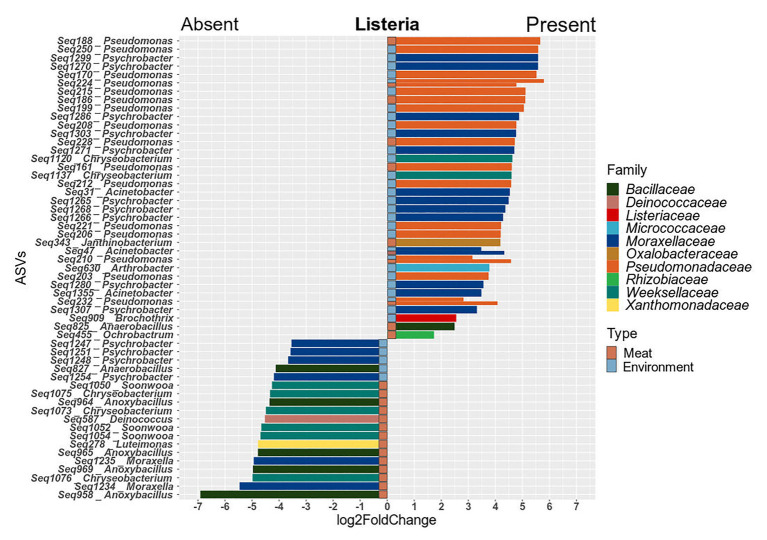
Barplots of ASVs that were significantly differentially abundant (p ≤ 0.05) between meat and surface samples with and without listeria. Positive values indicate higher abundance in samples with listeria and negative values depict higher abundance in samples where listeria is absent. Significant ASVs are plotted individually and colored according to their family-level classification.